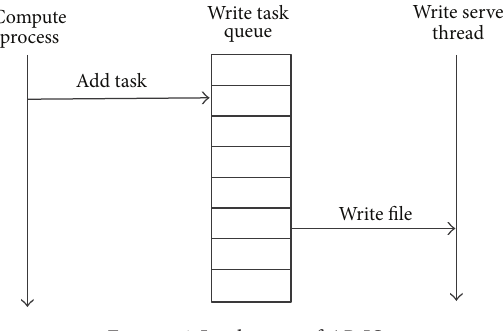
Figure 6: Implement of AP-IO